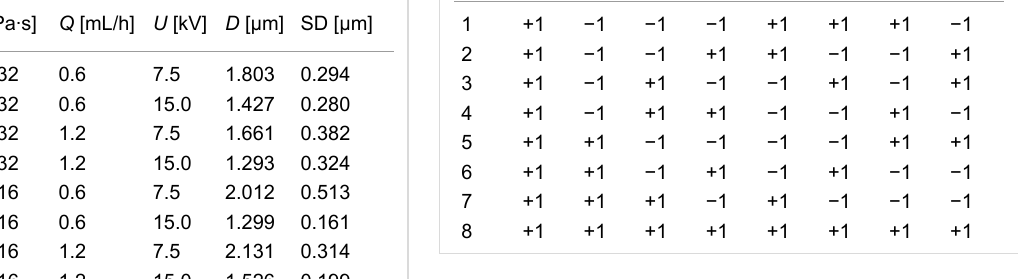
Table 4: Experimental variants for a 2 3 factorial design including the average diameter of the obtained beadless fibers ( D ). SD is the stan- dard deviation.